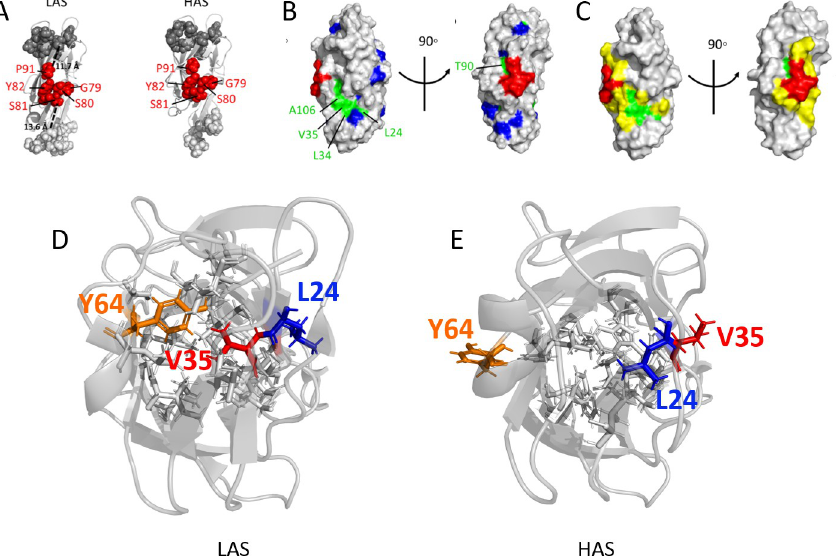
Fig 2. Epitope of mAb824 mapped on the FimH lectin domain structure. (A) Views of crystal structures of the FimH LD in the LAS (PDB code 4xo9) and HAS (PDB code 4xo8) conformations. Residues whose mutation affected mAb824 binding are labeled and shown as red spheres. Ligand-binding pocket residues on the “top” of the lectin domain are shown as dark grey spheres and the interdomain region residues on the “bottom” are shown as light grey spheres. (B) Surface rendition of LD (PDB code 3zpd) showing residues with large perturbations in the NMR spectrum upon Fab824 binding (green). Methyl residues that do not exhibit large perturbations are shown in dark blue. The mAb824 epitope determined by mutagenesis is shown in red. (C) The putative structural epitope of mAb824 mapped on an LD HAS structure (PDB code 3zpd). Residues immediately bordering the functional epitope (red) and the NMR-determined patch (green) are marked in yellow (N23, N33, D37, T74, K76, S78, P83, T86, E89, R92, V93, V105, Y108). (D) The V35/L34 and Y64 solvent-core switches. Ribbon representation of FimH lectin domain in LAS (PDB code 4xo9) and HAS (PDB code 4xo8) with the alternate orientations of V35 (red stick) and L34 (blue). Y64 (described later in study) is in orange sticks.